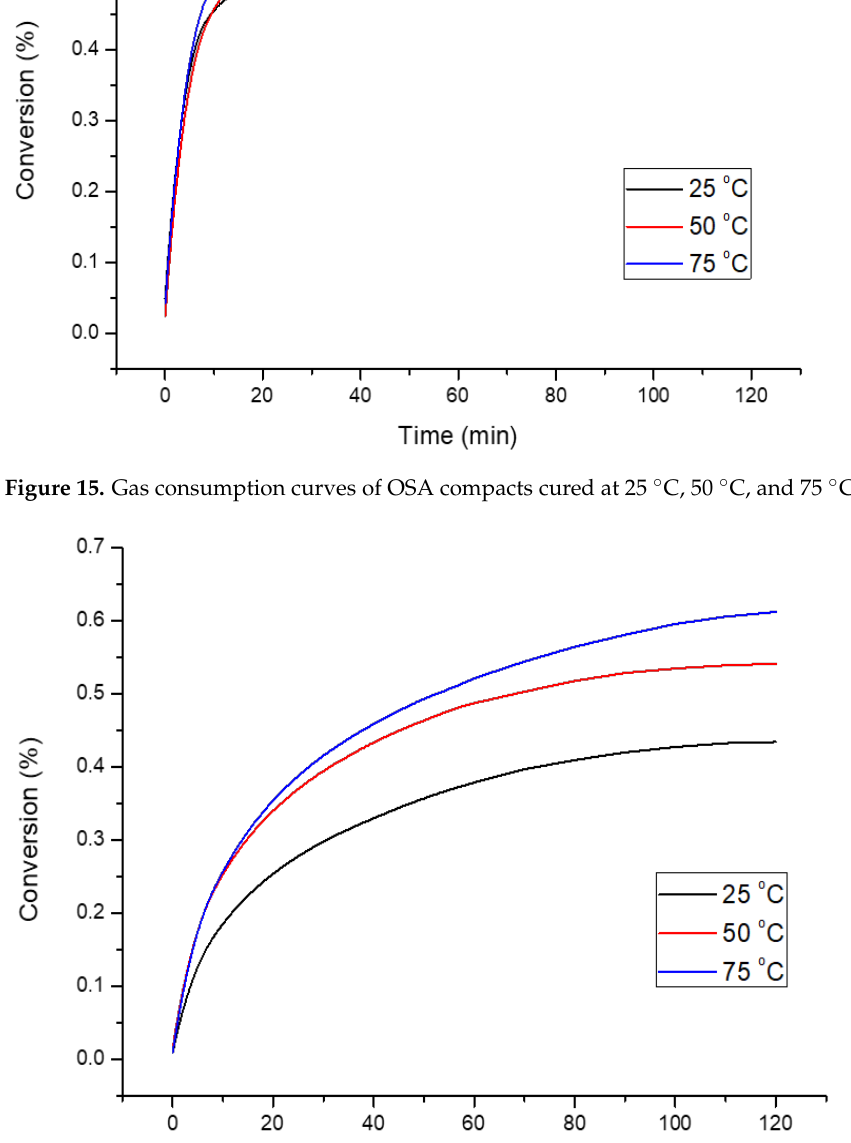
Figure 16. Gas consumption curves of WA compacts cured at 25 °C, 50 °C, and 75 °C.